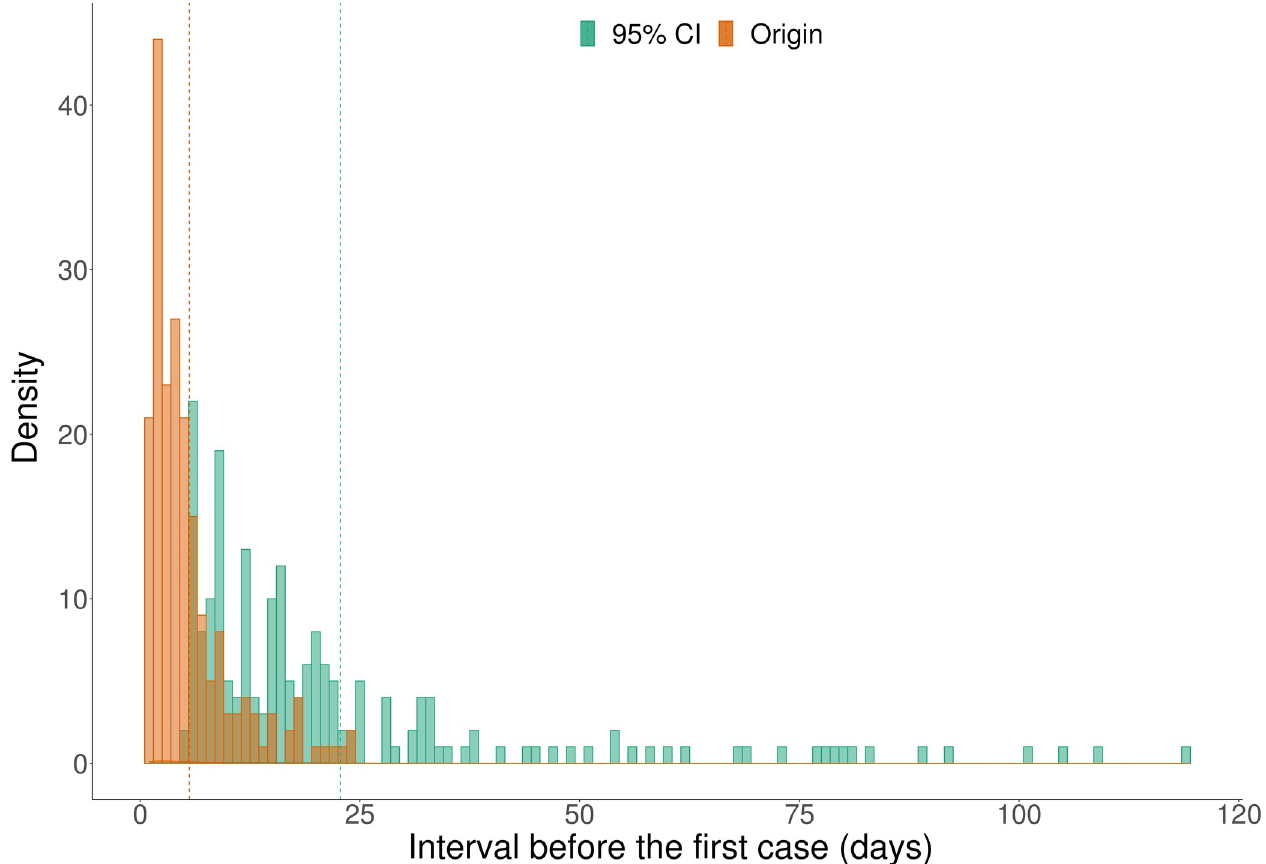
Fig 1. Histogram of intervals between estimated origin dates and first cases (Origin) and between upper bounds of 95% confidence intervals and first cases (95% CI). Vertical dashed lines represent mean